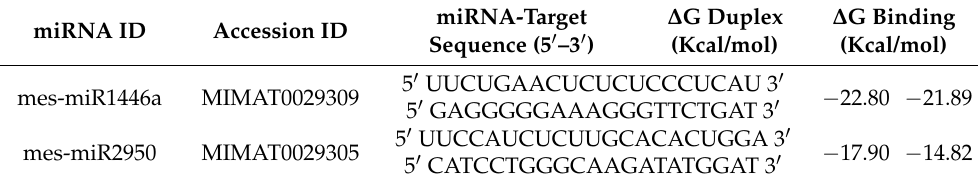
Table 7. The free energy ( ∆ G ) of the consensus cassava locus-derived mes-miRNA-mRNA target pairs was